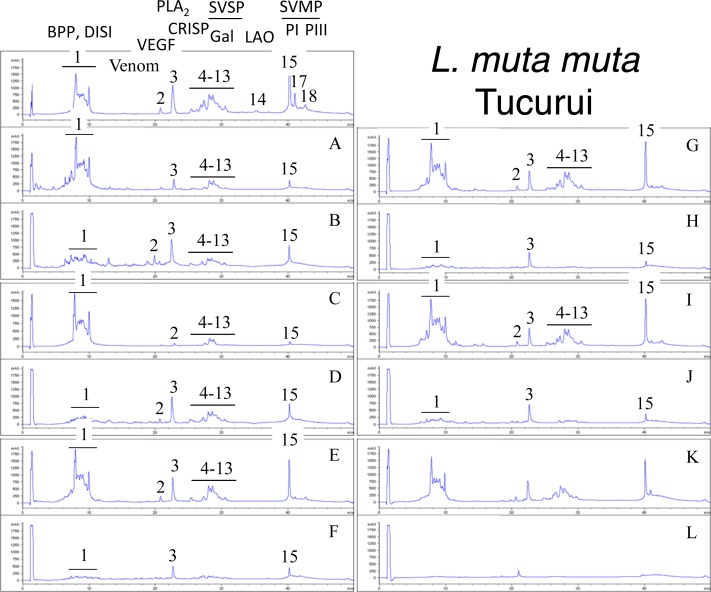
Immunoaffinity chromatography-based antivenomic analysis of the immunoreactivity of polyspecific and monospecific antivenoms towards the venom of L. muta muta from Tucurui (Brazil).Panels display reverse-phase separations of whole venom components, and non-retained (A, C, E, G, and I) and the retained (B, D, F, H, and J) fractions recovered, respectively, from the affinity columns of immobilized BCL, BL, AL, AB, and AC antivenoms. Panels K and L, non-retained and retained venom fractions by immobilized equine control immunoglobulins. CRISP, cysteine-rich secretory protein; other acronyms as in the legend of Fig 2.